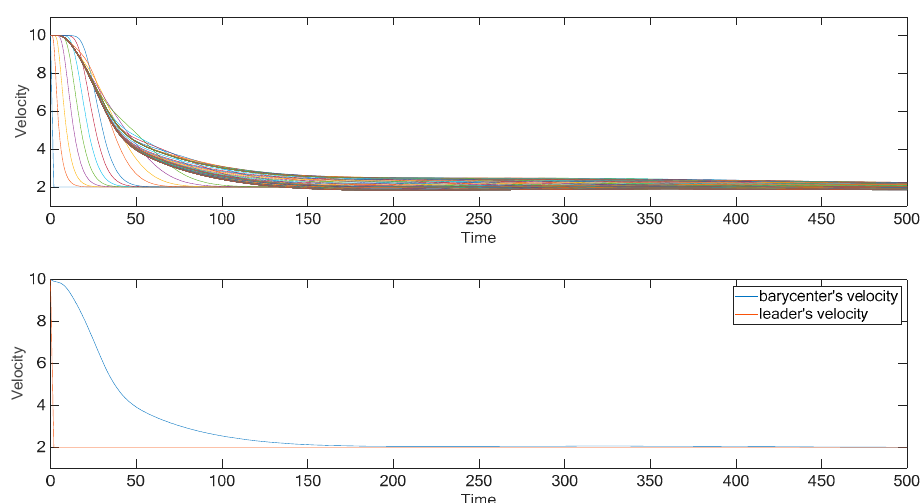
Figure 12. Small world model simulated with 100 vehicles and p = 0.1, excited by the braking maneuver imparted by the leader Equation (15). The velocity of each following vehicle, on ( top ), and velocity of the Leader and velocity of the barycenter, on the ( bottom ), plotted versus time.